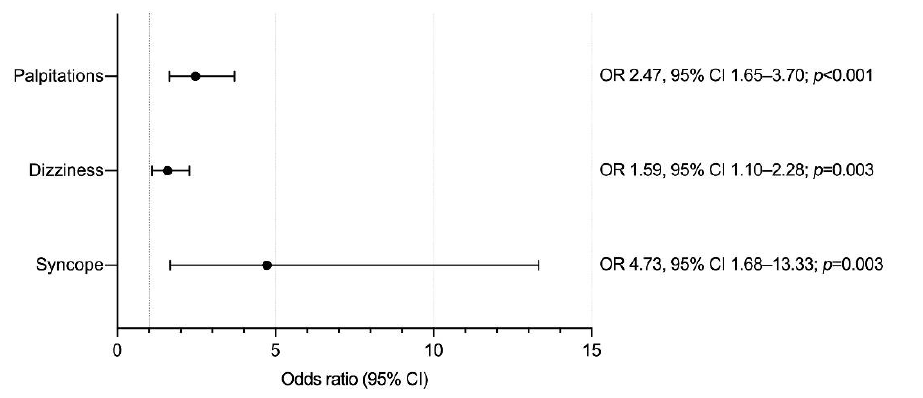
Abbreviations: IQR, interquartile range, SARS-CoV-2, severe acute respiratory syndrome corona- virus 2.